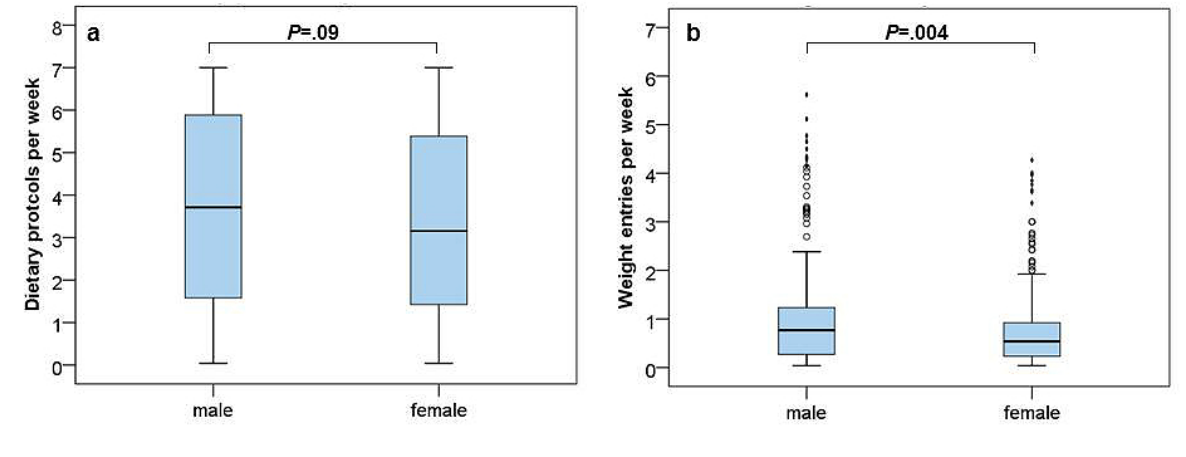
Figure 7. Gender-specific use of program tools in the first 6 months of program participation. Dietary protocols (a) were used more frequently by men, who also entered significantly more body weights per week (b) than